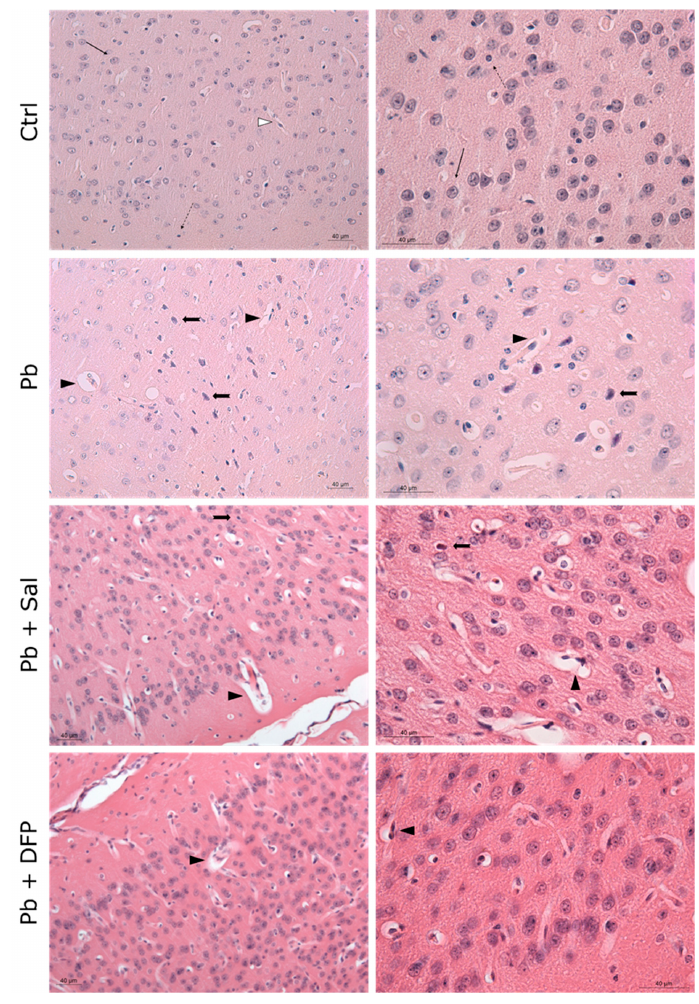
Figure 3. Light microphotographs of the cerebral cortex of experimental mice. Ctrl—untreated control mice. Intact neurons (black, thin arrow), glial cells (black, dotted arrow), and perivascular spaces (white arrowhead). Pb—Pb-exposed group. Numerous pyknotic neurons (black, thick arrow) with prominent perineuronal spaces, dilated perivascular spaces (black arrowhead), and reactive endothelial cells; Pb + Sal—Pb-exposed mice, subjected to treatment with salinomycin. A few pyknotic neurons (black, thick arrow) with prominent perineuronal spaces, dilated perivascular spaces (black arrowhead), and reactive endothelial cells; Pb + DFP—Pb-exposed mice, subjected to treatment with deferiprone. A few dilated perivascular spaces (black arrowhead), and reactive endothelial cells. Hematoxylin-eosin staining, ×200; ×400.